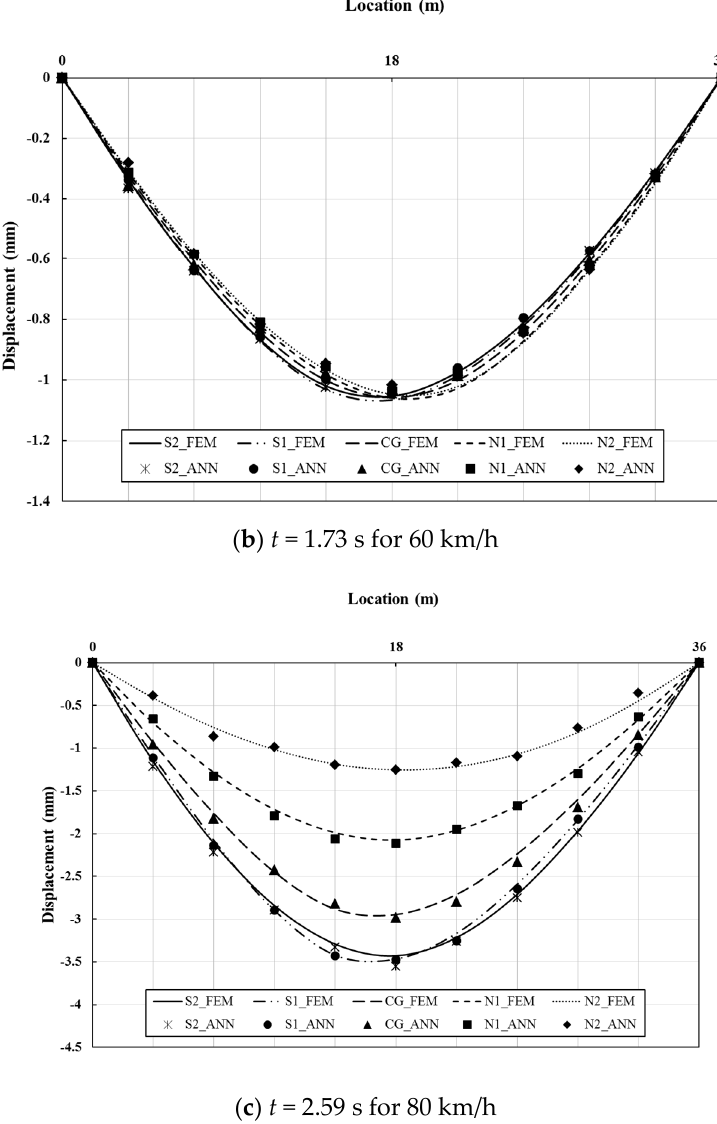
Figure 14. Overall behavior of girder at maximum